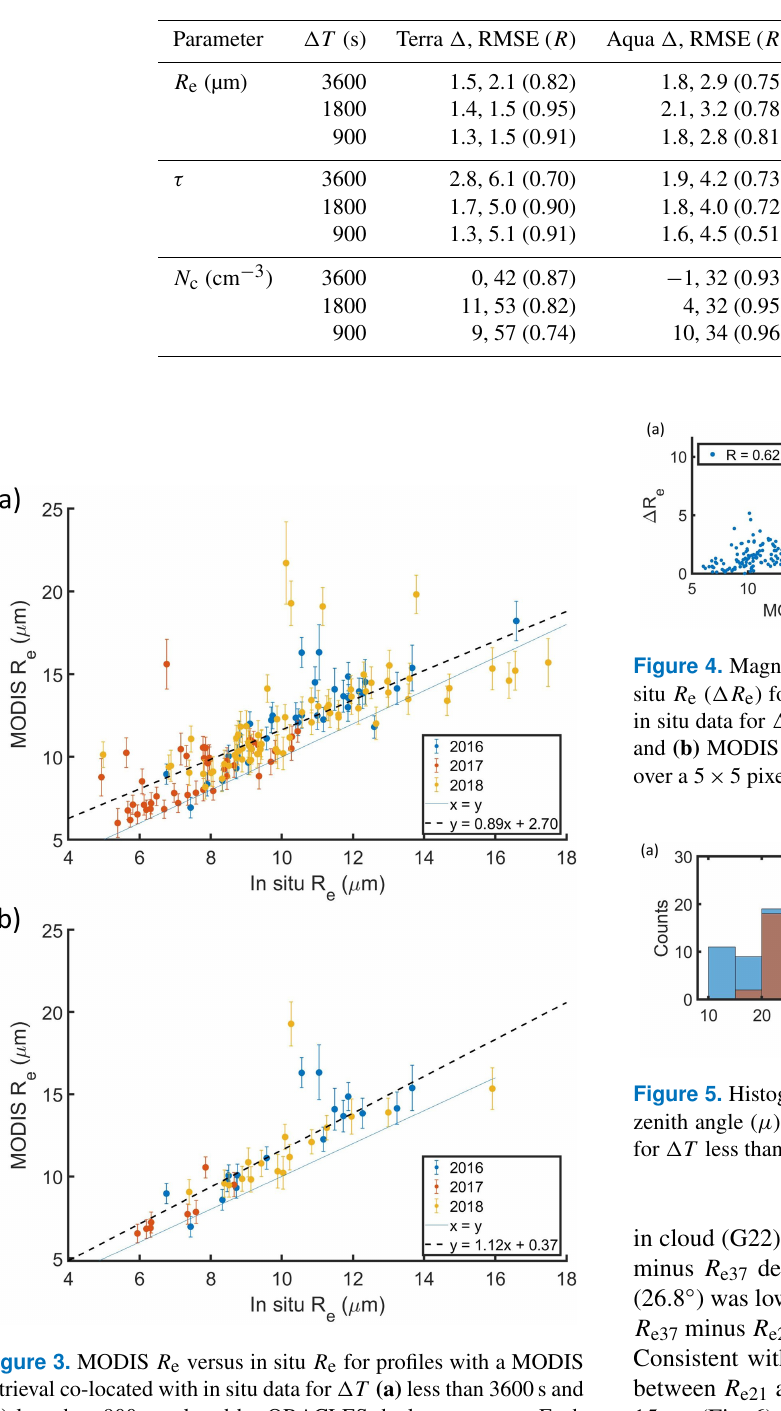
Table 3. Average bias ( (cid:49) ), root mean square error (RMSE), and Pearson’s correlation coefficient ( R ) for MODIS (Terra, Aqua, combined) retrievals relative to in situ R e , τ , and N c for different (cid:49)T .